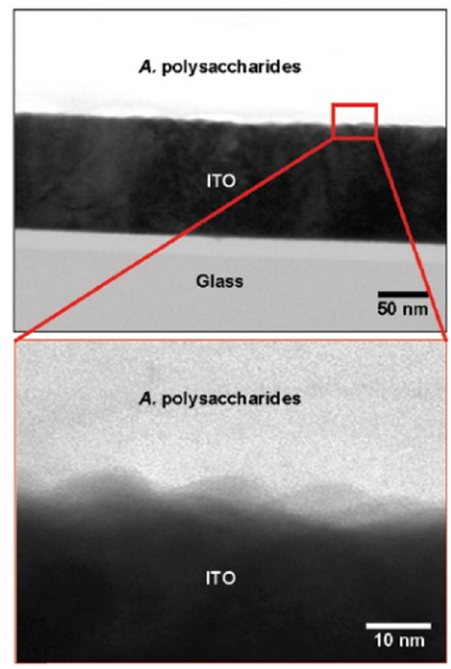
Table 7: Standard electrode reduction potential series [ 87 – 89 ]